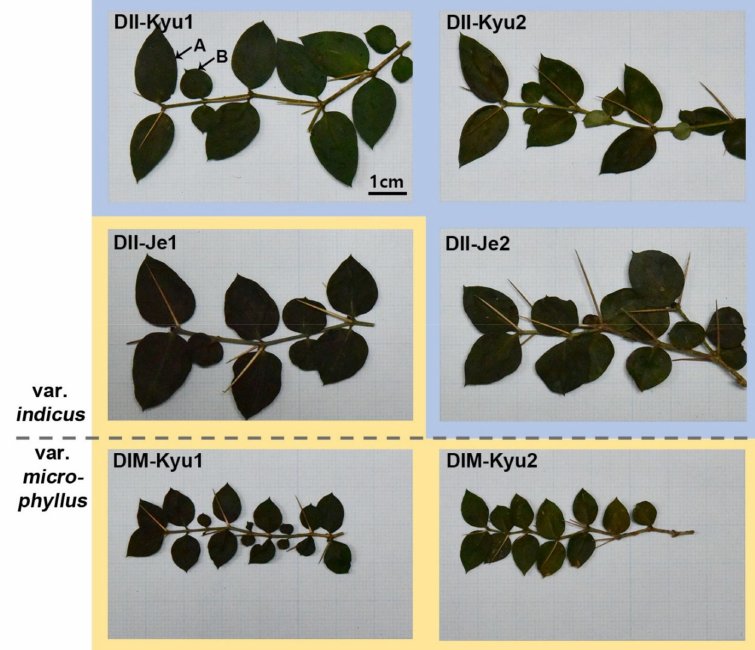
Figure 1. The morphology of six individuals of Damnacanthus indicus . A dashed horizontal line represents the division between var. indicus (upper four) and var. microphyllus (lower two). Each individual is marked with its acronym (see Table 1). D. indicus is heterophylly with relatively large and small leaves alternately appearing and characterized by a length of spines that is more than half the length of the leaves. The heterophyllous leaves in DII-Kyu1 are indicated (A = large, B = small). D. indicus is divided into two varieties according to leaf length; var. indicus has a leaf length of 1–2 cm and var. microphyllus has a leaf length of 0.5–1 cm. According to our observations, var. microphyllus is conspicuously smaller than var. indicus in the size of the leaves, the height of the plant and the length of the spines. The colored boxes represent the phylogenetic distinction; the blue part is cluster1 and the yellow network is cluster2. Each image size is equal to 8x5 cm. Scale bar = 1